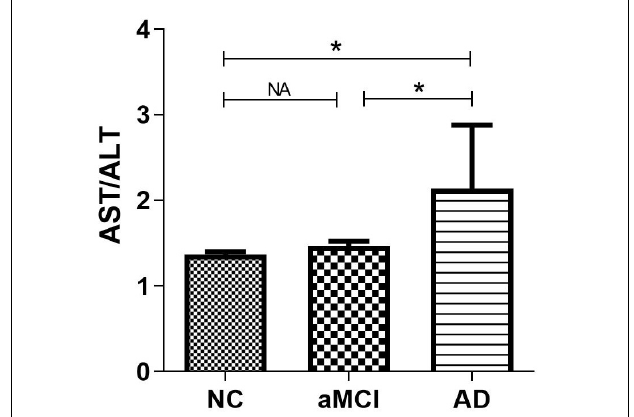
FIGURE 1 | Compare the differences of AST/ALT among three groups. * p < 0.05; NA, p < 0.05; AST, aspartate aminotransferase; ALT, Alanine